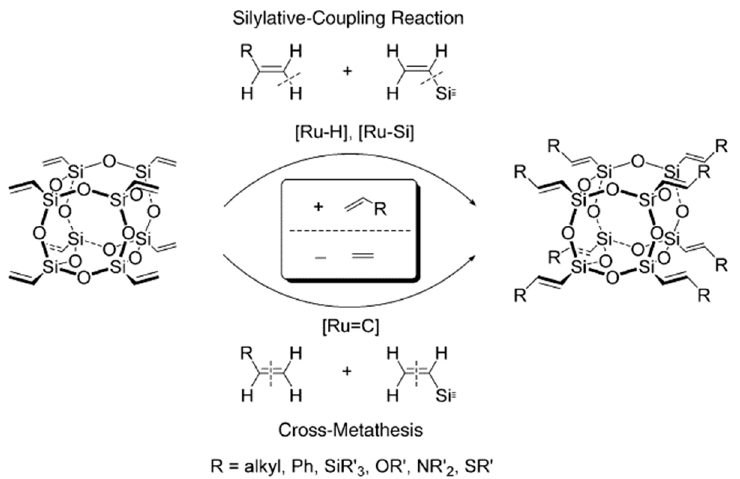
Figure 17. The combined reaction schemes for silylative coupling and cross metathesis. Reproduced with permission from Ref. [61]. Copyright 2004 John Wiley and